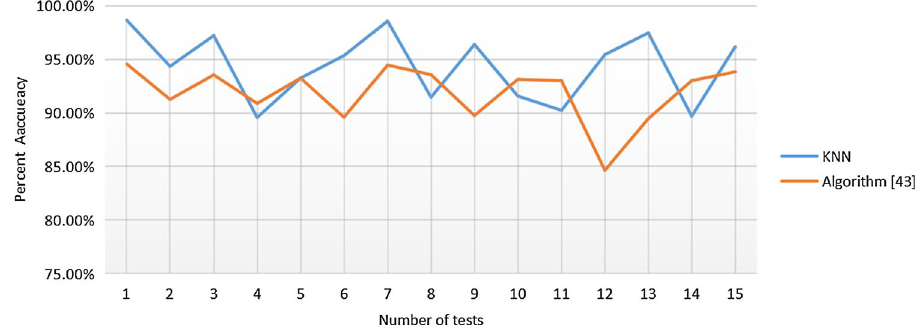
Fig. 2 Average accuracy rate (single degree of